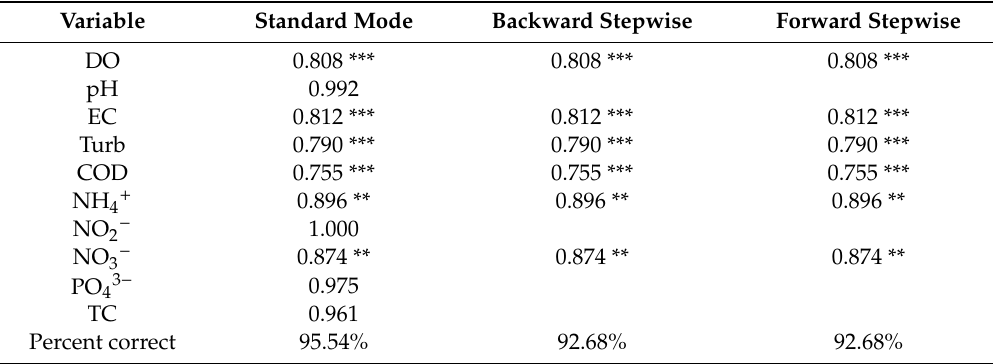
Table 4. Unidimensional lambda test of equality of water quality